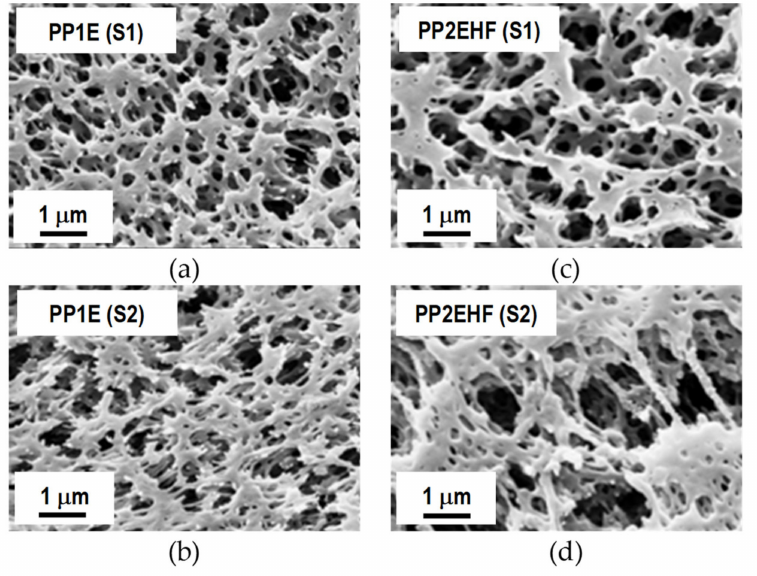
Figure 5. FESEM micrographs of the two surfaces (S1 and S2) of PP1E ( a , b ) and PP2EHF ( c , d ) mem-